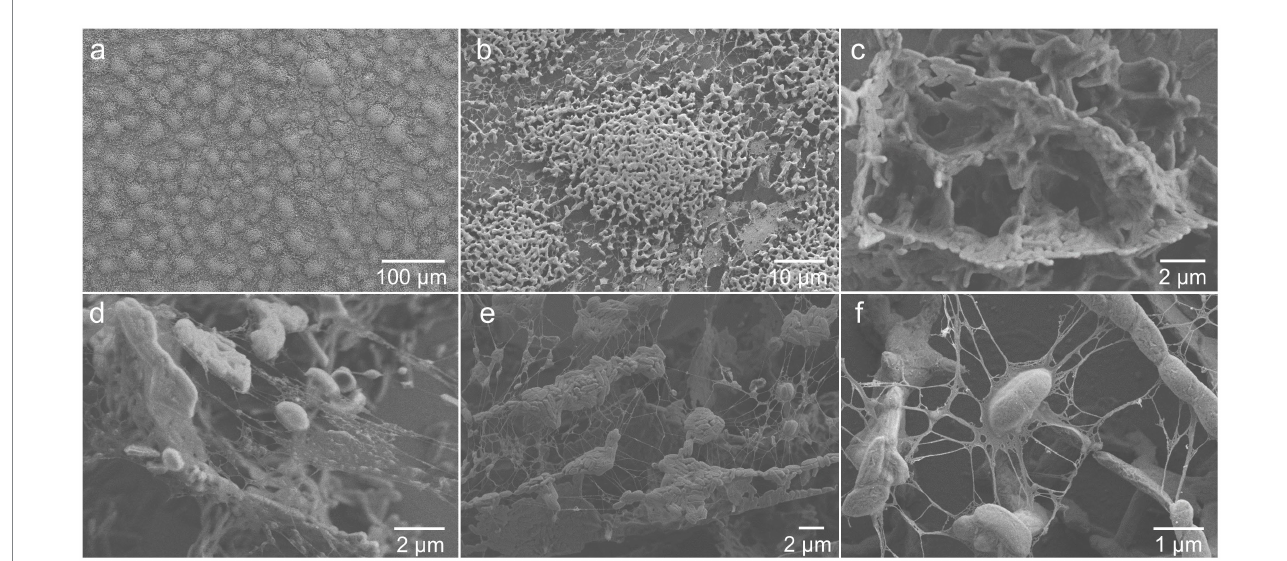
FIGURE 3 Cryo-SEM images showing extracellular matrix surrounding (A,B) colonies and (D-F) individual cells, as well as (C) an example of cell organization in a colony, of 3-day-old G. sulfurreducens biofilm grown in standard nutritive medium amended with vitamins.